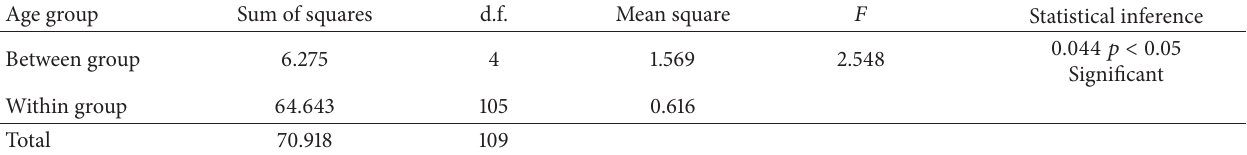
Table 8: ANOVA among occupational status of employees about the opinion of CRM strategy in Banking Industry in Madurai District. Age group Sum of squares d.f. Between group Within group Source: computed